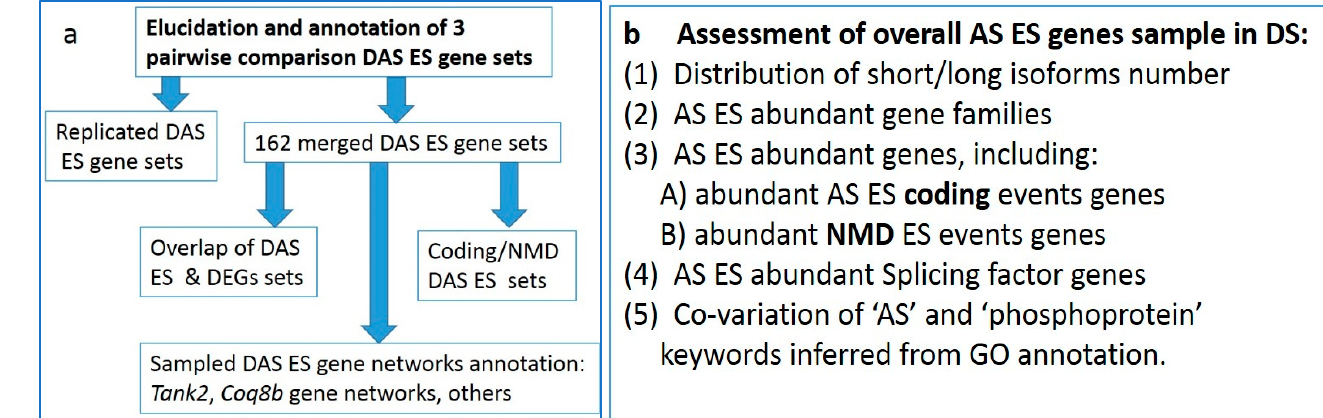
Figure 3. Workflow scheme for data analysis: ( a ) DAS genes analysis; ( b ) whole genome AS capable gene analysis.